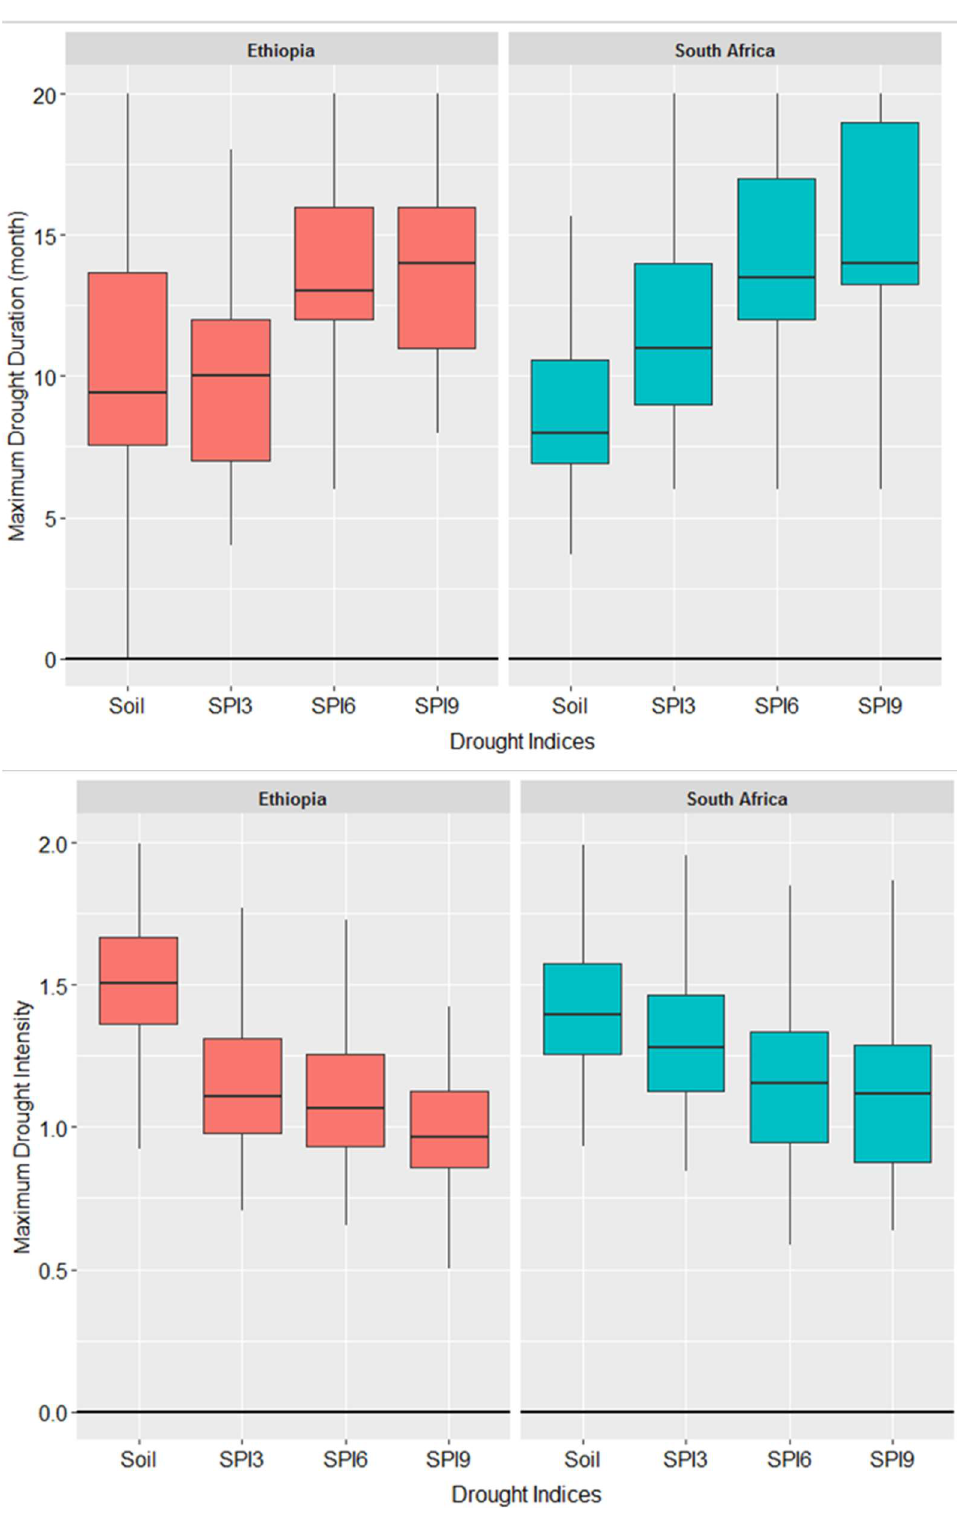
Figure 9. Comparison of percentage of months with drought conditions, maximum drought duration, and drought intensity over Ethiopia and South Africa for multiple drought indices. The center line of each boxplot depicts the median value (50th percentile) and the box encompasses the 25th and 75th percentiles of the sample data. The whiskers extend from q1 − 1.5 × (q3 − q1) to q3 + 1.5 × (q3 − q1), where q1 and q3 are the 25th and 75th percentiles of the sample data, respectively.